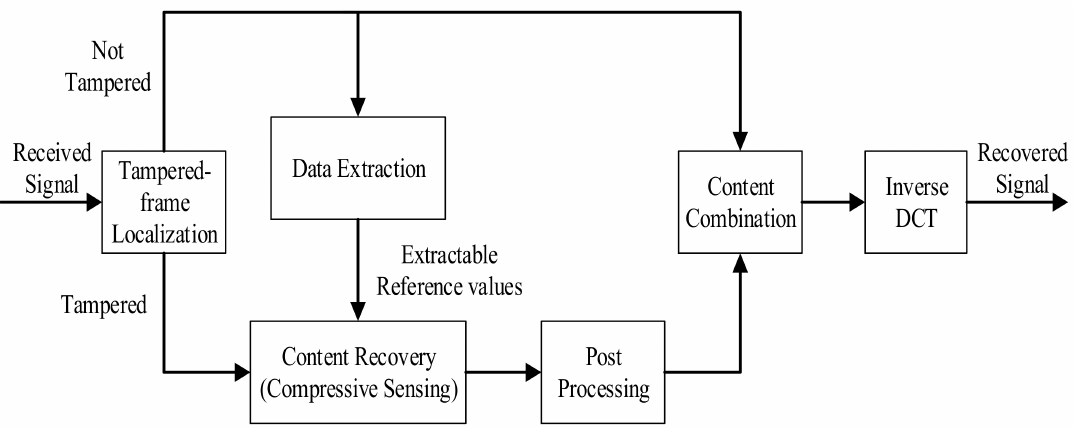
Figure 2. Sketch of watermark recovery